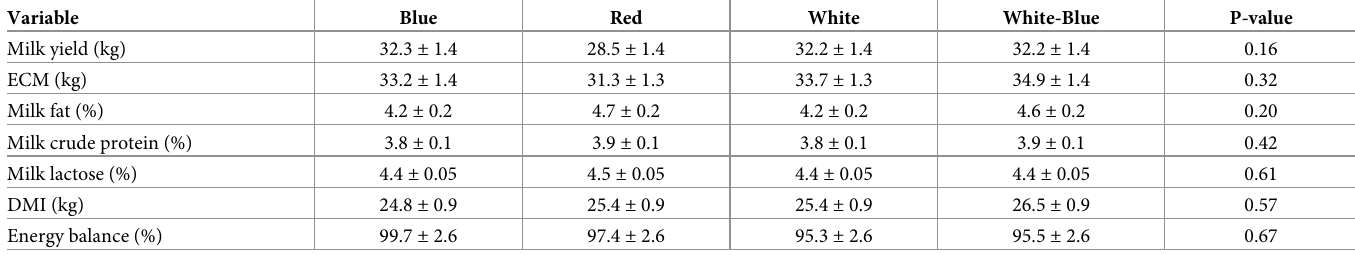
Table 3. Least squares mean (LSM) ± standard error of: Milk yield, energy-corrected milk (ECM), milk composition, dry matter intake (DMI), and energy balance for cows exposed to the Blue, Red, White and White-Blue light treatments. Variable Blue Red